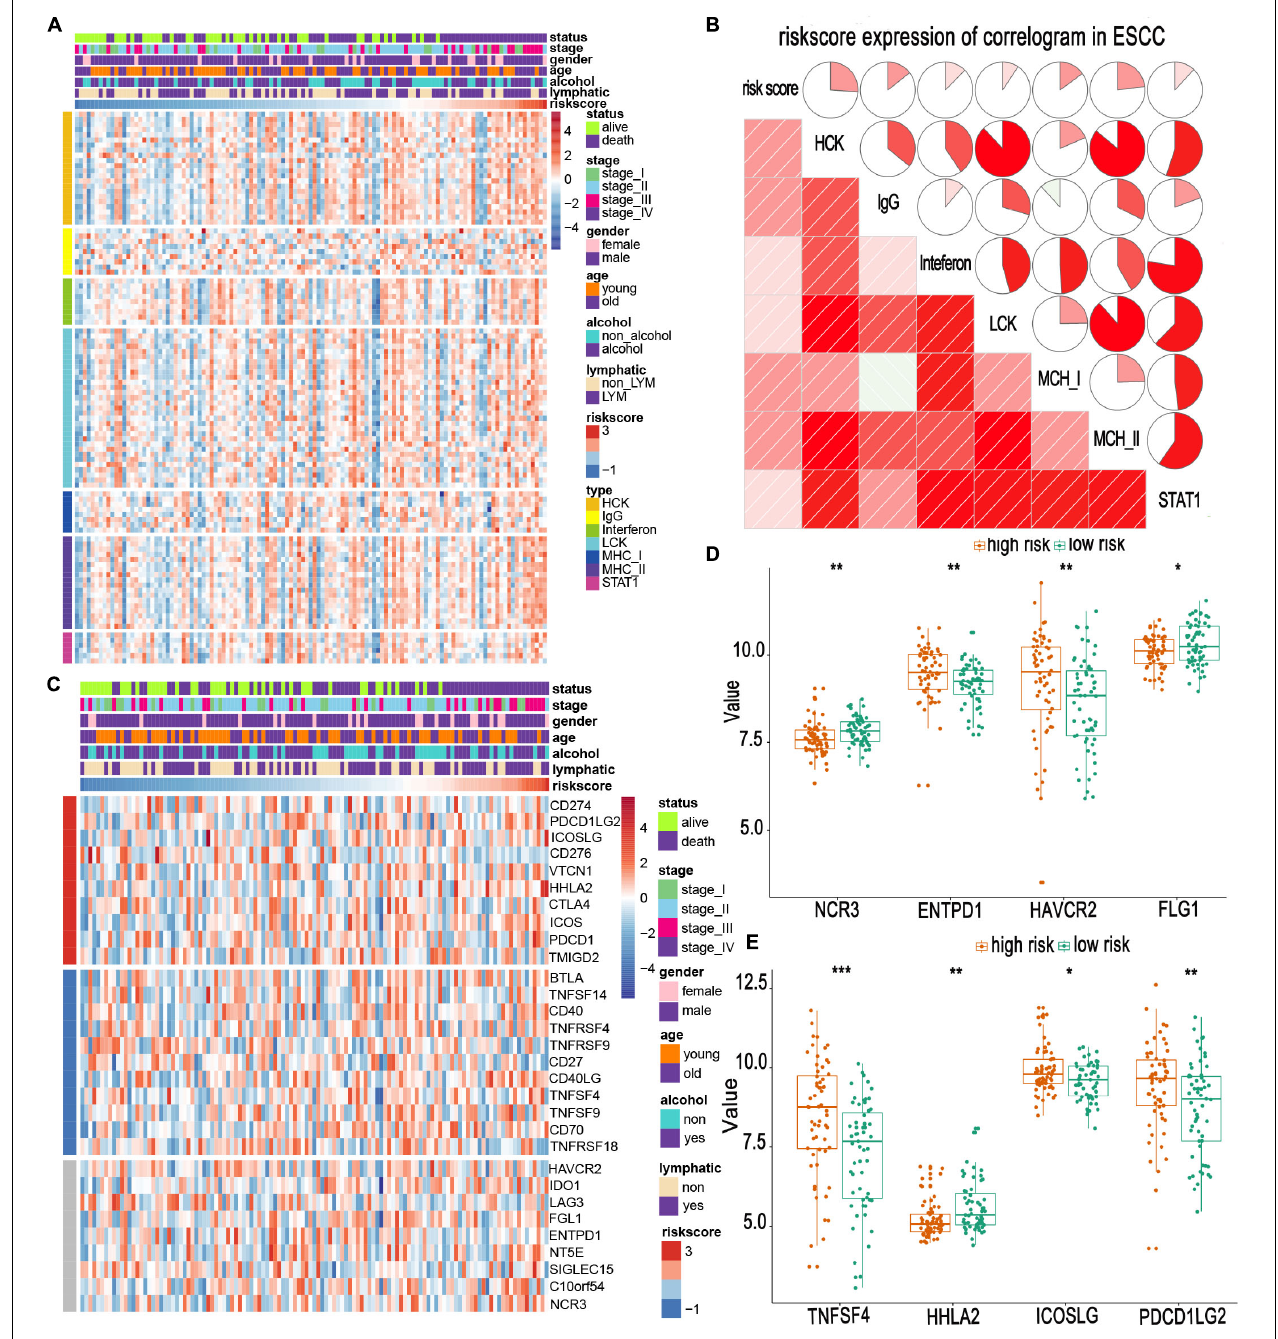
FIGURE 5 | Relationship between risk scores and immune metagenes and immune checkpoints. (A,C) Expression of metagenes heatmap and corrgram in the training cohort. (B) The expression profile of immune checkpoints landscapes in the training cohort. (D,E) Different expression of immune checkpoints in high- and low-risk groups. *, **, and *** represent P < 0.05, P < 0.01, and P < 0.001, respectively. Young and old represent age < 60 and age ≥ 60 years,